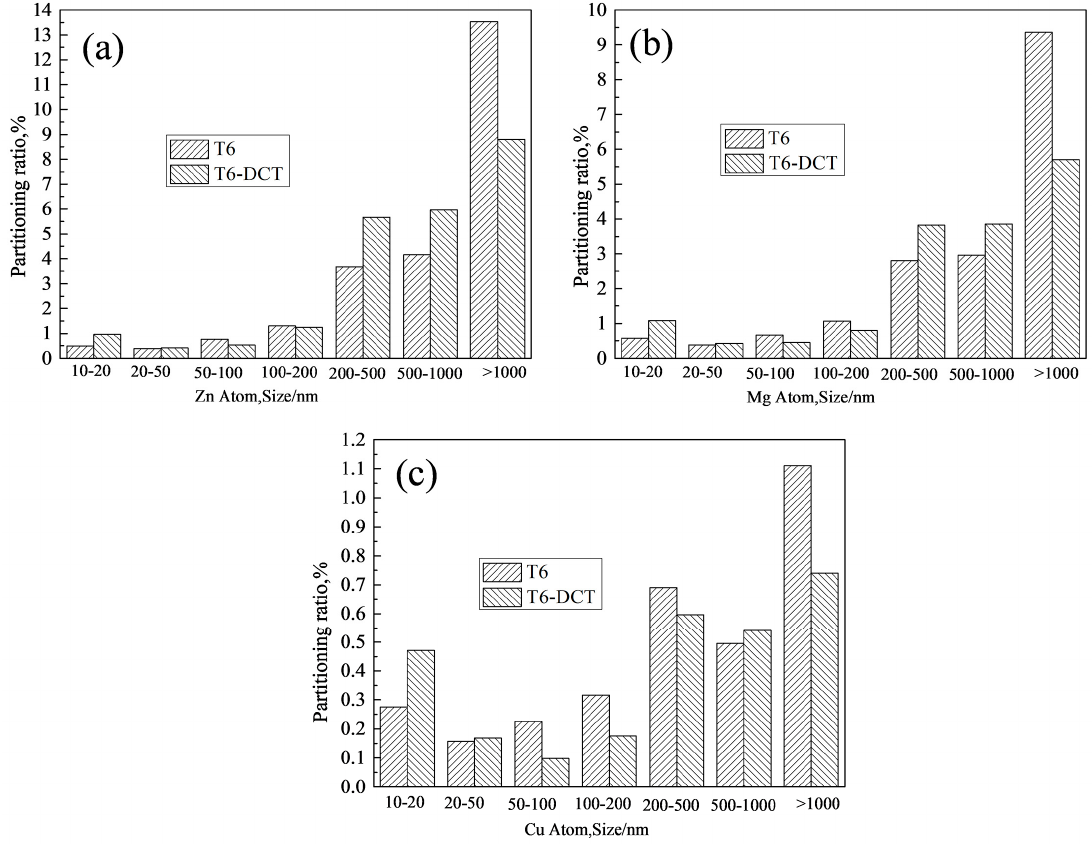
Figure 5. Size distribution of Zn, Mg, and Cu atom clusters in T6- and T6-DCT-treated 7A99 alloy. ( a ) Zn; ( b ) Mg; and ( c ) Cu.